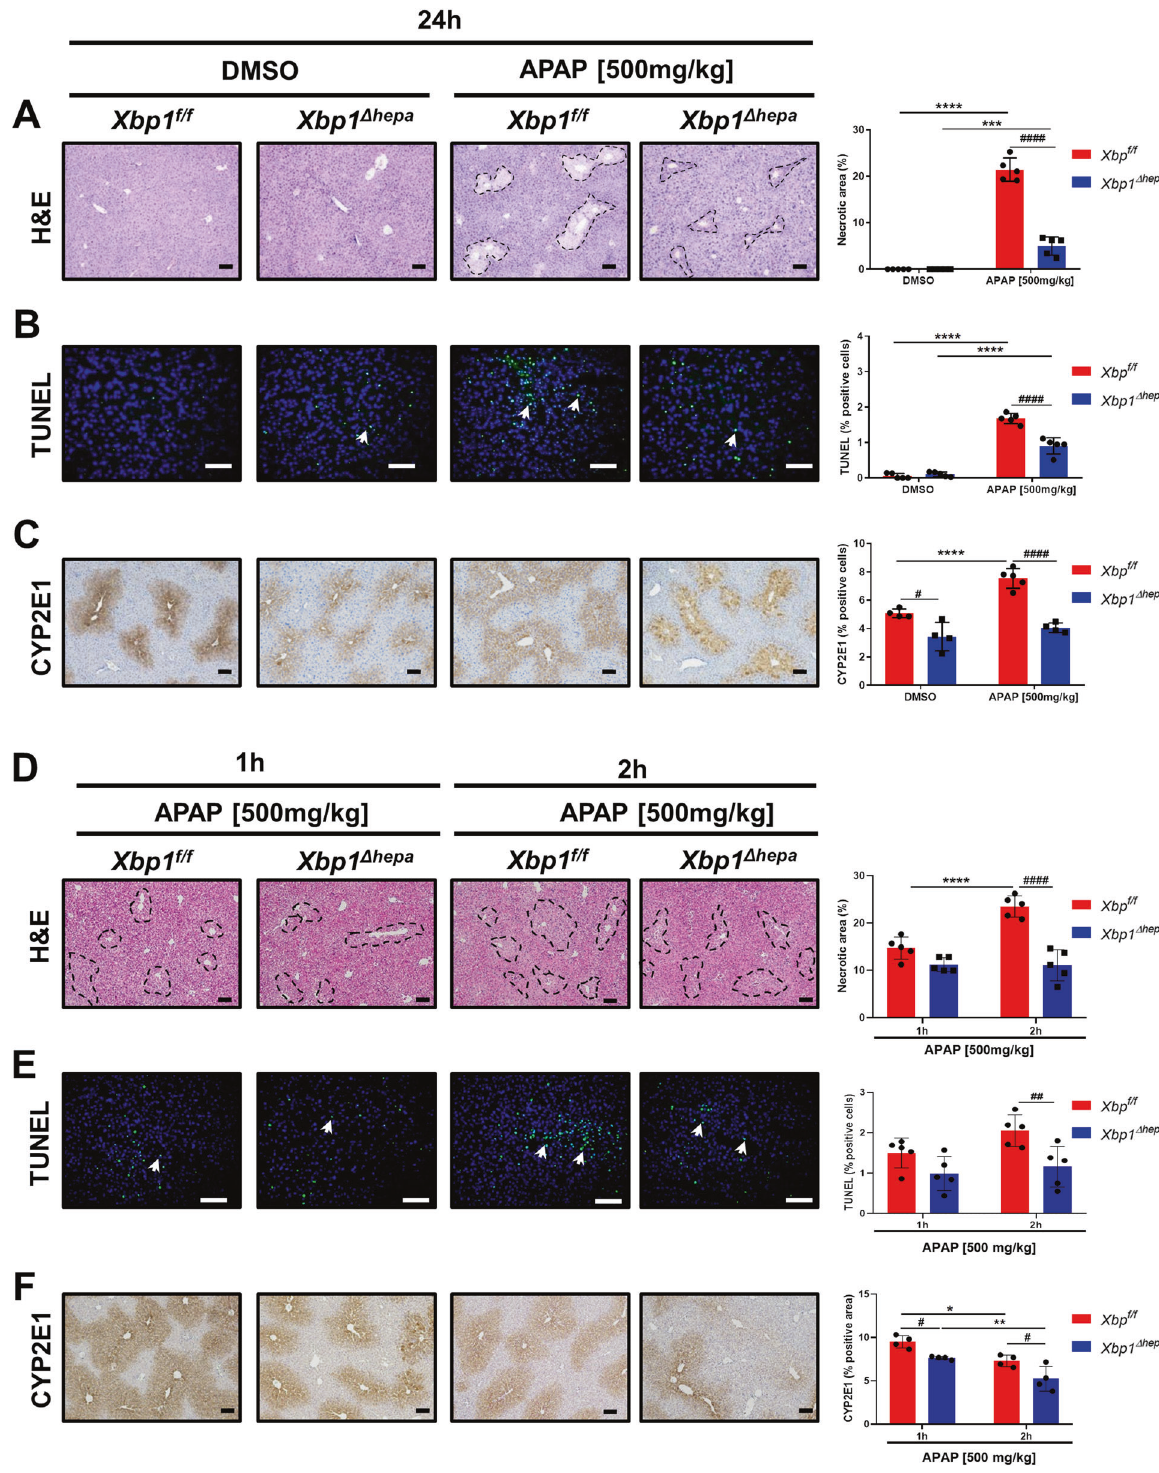
Fig. 3 Ablation of Xbp1 in hepatocytes reduces hepatotoxicity both at early and late stages of high dose APAP. Xbp1 f/f and Xbp1 Δ hepa mice were challenged with APAP [500 mg/kg] at late (24 h) and early (1 – 2 h) stages of hyperacute liver injury. A Representative H&E staining was performed in paraf fi n liver sections of Xbp f/f and Xbp1 Δ hepa animals, 24 h post-APAP, Necrotic foci were quanti fi ed. Scale bars, 100 μ m. B Representative TUNEL staining performed on frozen liver sections. TUNEL-positive cells per view fi eld were quanti fi ed. Arrows denote positive cells. Scale bars, 100 μ m. C Representative IHC staining for CYP2E1 for the same samples and quanti fi cation of CYP2E1 area per view fi eld. Scale bars, 100 μ m. D Representative H&E staining was performed in paraf fi n liver sections, 1 and 2 h after APAP injury and necrotic foci were quanti fi ed. Scale bars, 100 μ m. E Representative TUNEL staining performed on frozen liver sections of the same animals. TUNEL-positive cells per view fi eld were quanti fi ed. Arrows denote positive cells. Scale bars, 100 μ m. F Representative IHC staining for CYP2E1 for the same samples. Quanti fi cation of positive area per view fi eld using Image J was performed. Scale bars, 100 μ m. Data are expressed as mean ± SEM (* p < 0.05-**** p < 0.0001; # p < 0.05- ### p < 0.001; *intragroup, # intergroup; N = 5 – 6 per experimental group). Cell Death and Disease (2022)